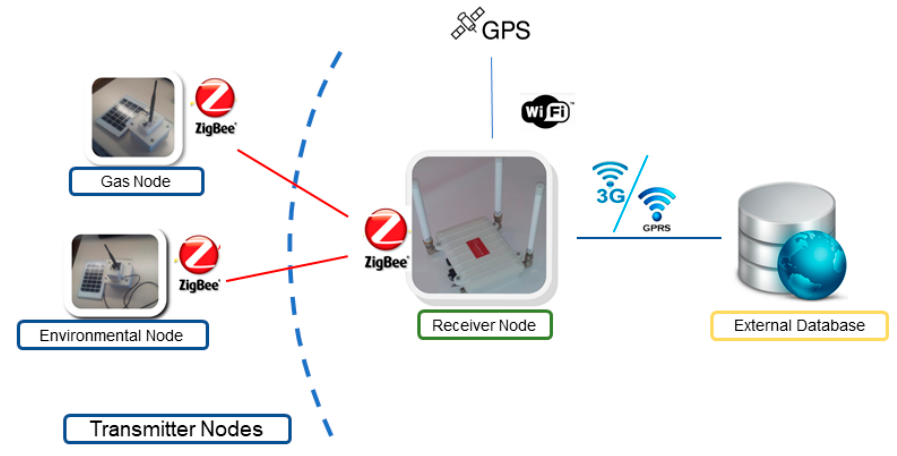
Figure 3. Architecture of the Mobile node.